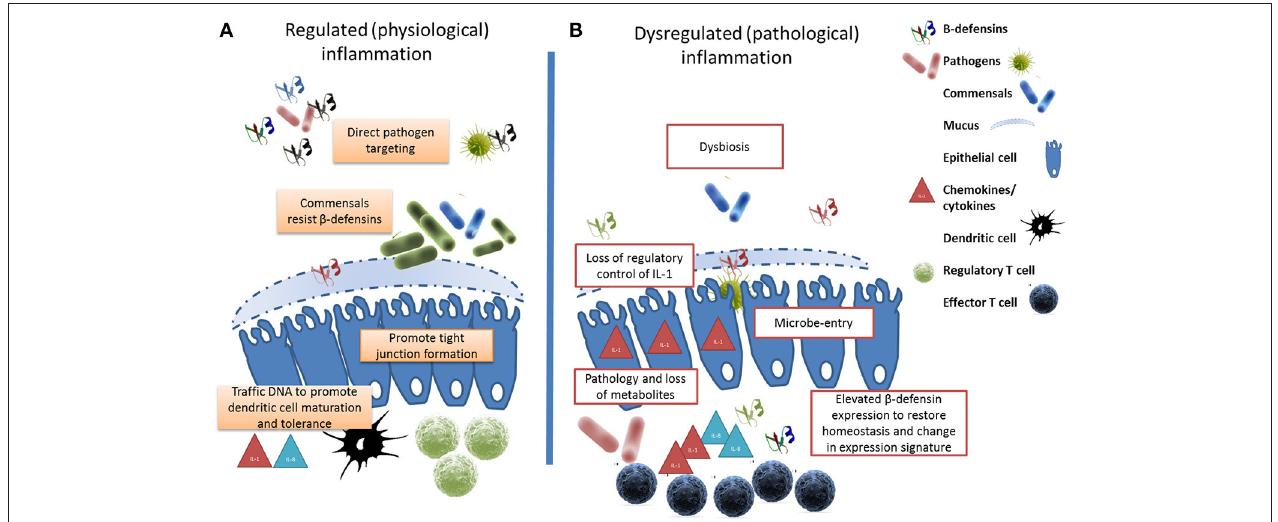
FIGURE 1 | β -defensins manage the microbial interface. (A) Under homeostatic conditions, β -defensin-mediated preferential trafficing of microbes to dendritic cells promotes the induction of tolerance and the control of inflammation. Similarly, prenatal expression of β -defensins induces inflammatory anergy while education of the immune system occurs. (B) Stessor-induced dysbiosis results in dysregulation of inflammation and the loss of metabolites due to cell damage leads to a bloom of pathobionts. In an effort to restore homeostasis, elevated β -defensin expression occurs resulting in a changed expression signature. The genes encoding these host defense peptides vary in number between individuals resulting in a personal β -defensin signature which may be more or less effective at preventing a switch to pathological